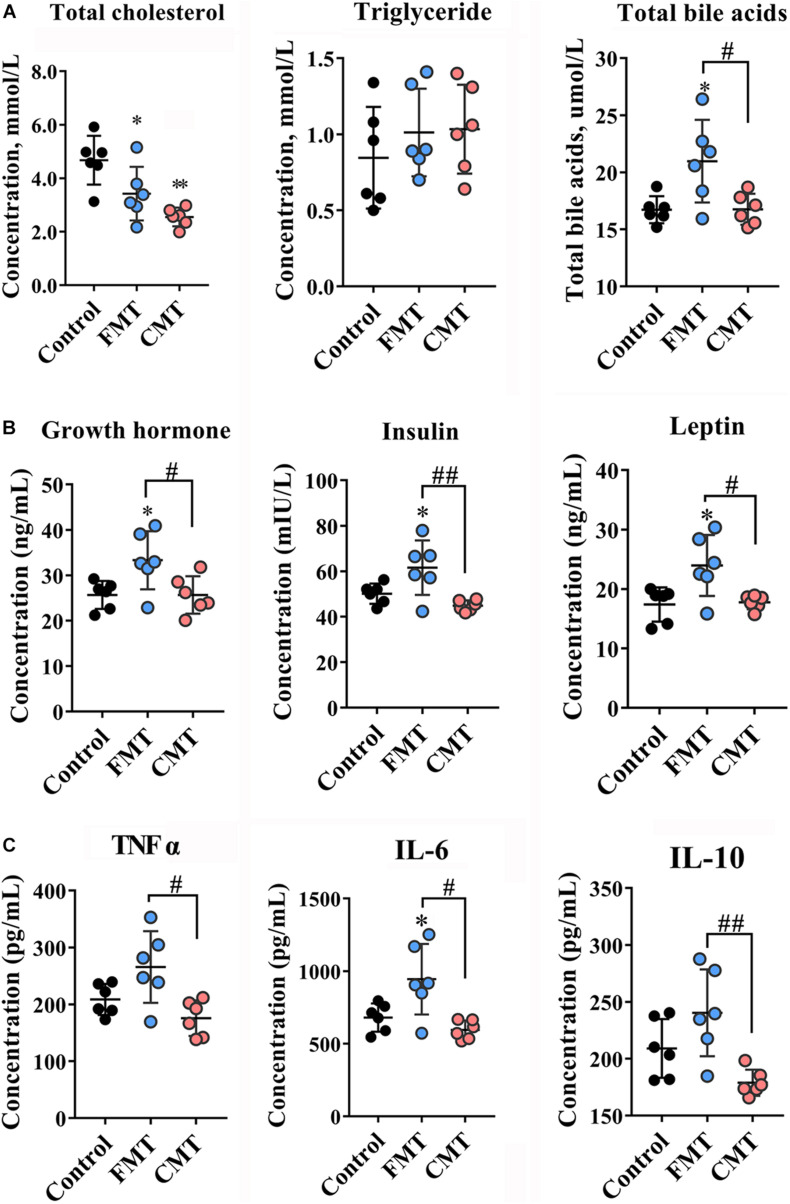
Microbiota transplantation changed blood index of recipient piglets. (A) Lipid contents (total cholesterol, triglycerides, total bile acids) in the blood of piglets (n = 6). (B) Contents of hormones related to growth (growth hormone, insulin, leptin) in the blood of piglets on day 28 (n = 6). (C) Inflammatory factors (TNF-α, IL-6, IL-10) in the blood of piglets on day 28 (n = 6). CMT, colonic microbiota transplantation; FMT, fecal microbiota transplantation. The data are presented as the mean ± SD. ∗∗ Indicates P < 0.01, and ∗ indicates P < 0.05 compared with the control; ## indicates P < 0.01, and # indicates P < 0.05 between the FMT and CMT groups.